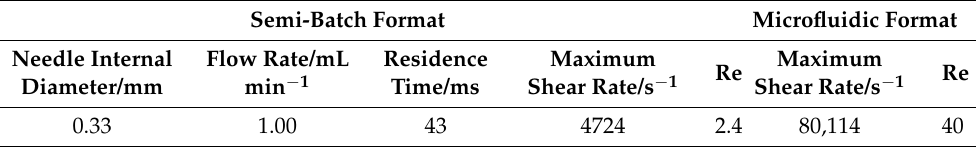
Table 2. Estimated flow properties of the open semi-batch format and the microfluidic format 1 . Shear-induced and antisolvent-induced nucleation of silk were probable in microfluidic format and at a large volumetric scale in the semi-batch